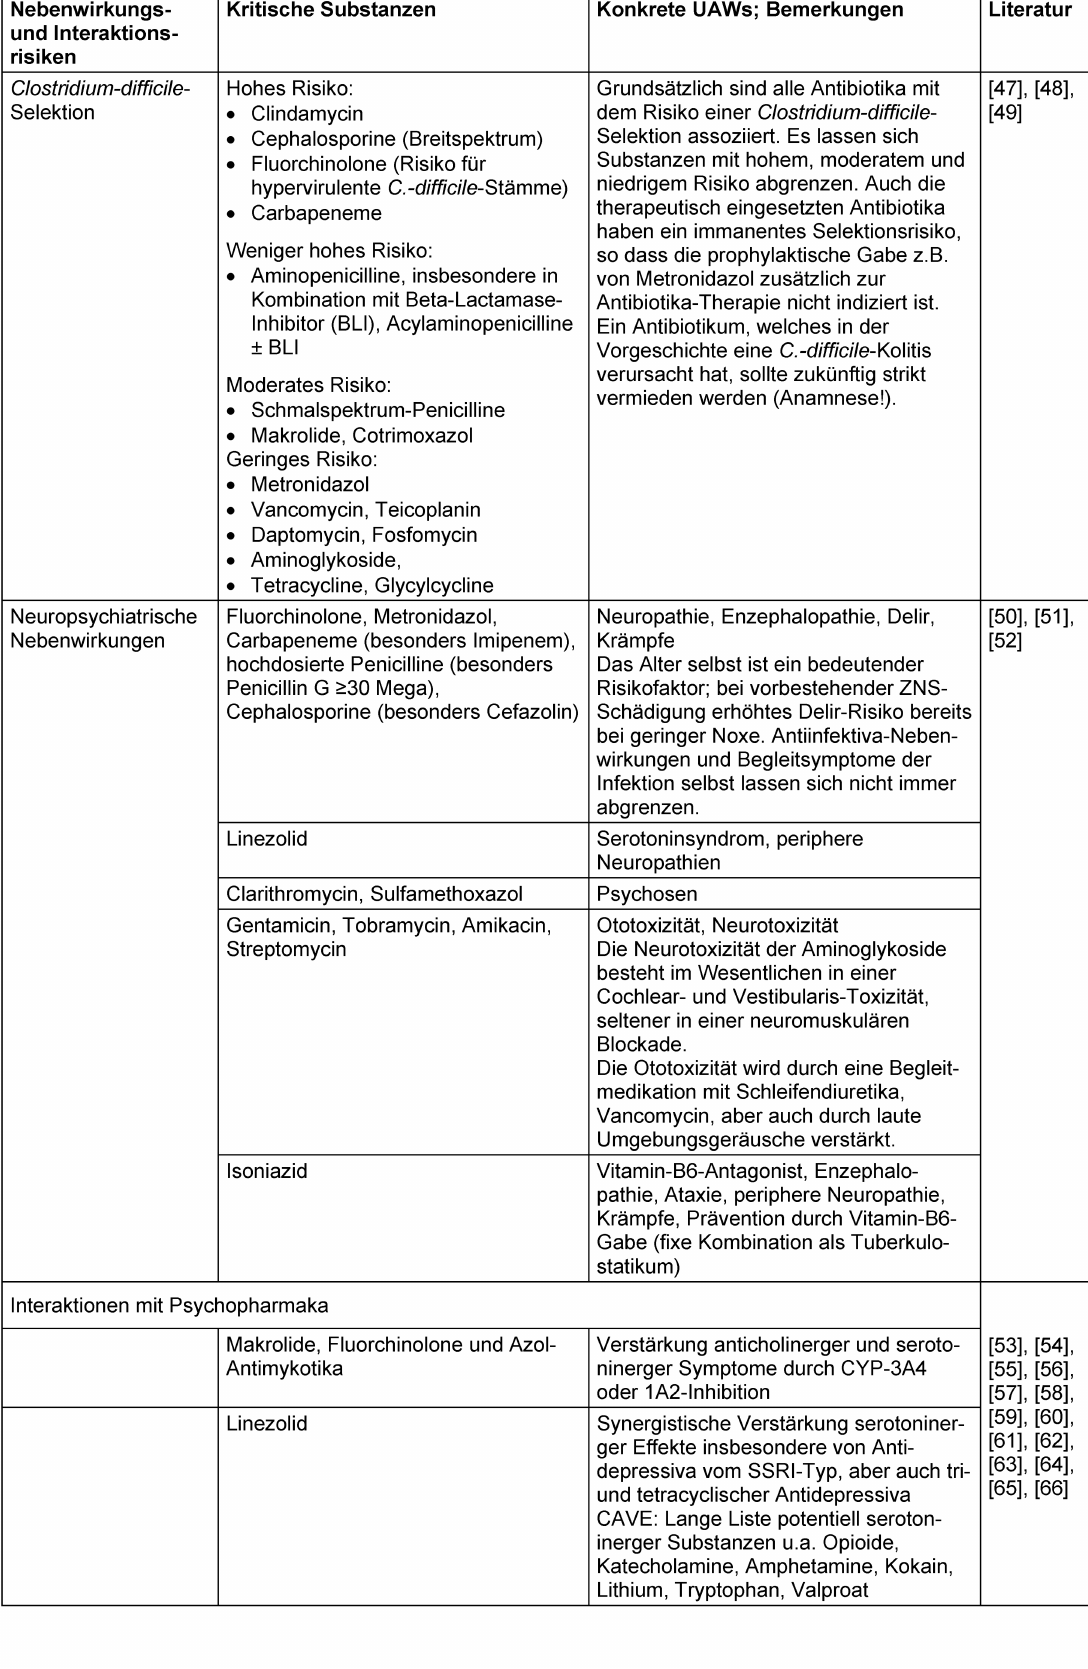
Tabelle 3: Bewertung der einzelnen Antibiotikaklassen bzw. einzelner Substanzen daraus nach Nebenwirkungen